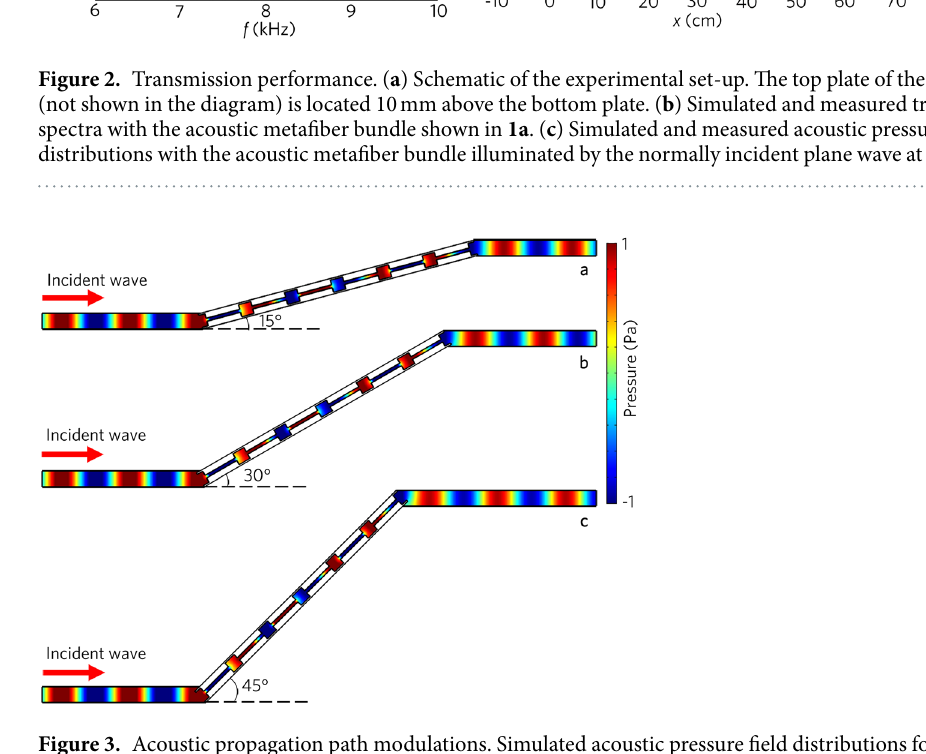
Figure 3. Acoustic propagation path modulations. Simulated acoustic pressure field distributions for the acoustic metafibers with different rotation angles ( a ) 15°, ( b ) 30° and ( c ) 45°, illuminated by the normally incident plane wave at 8.0